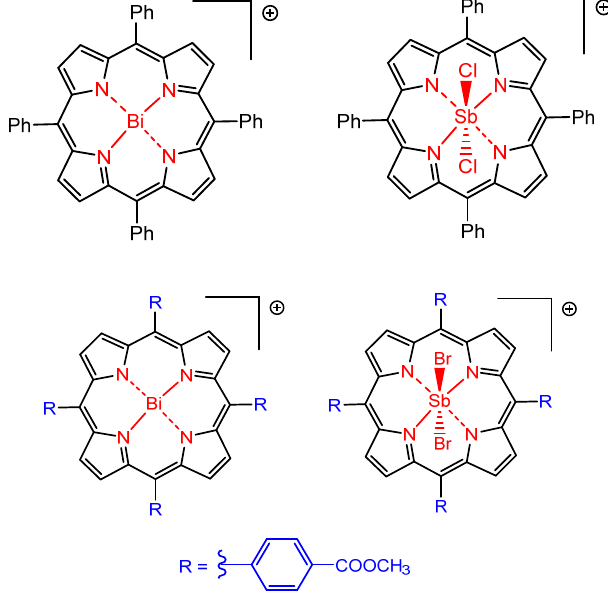
Figure 5. Molecular structures of the Bi(III) and Sb(V) porphyrin derivatives with activity against Leishmania amazonensis , by Gomes et al. [43].